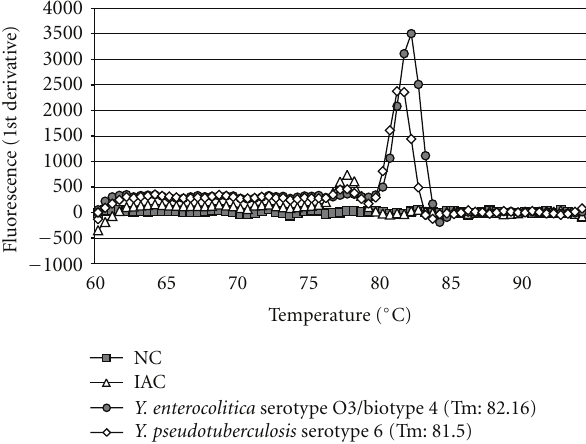
Figure 7: Y. enterocolitica and Y. pseudotuberculosis dissociation curve in SYBR Green real-time PCR